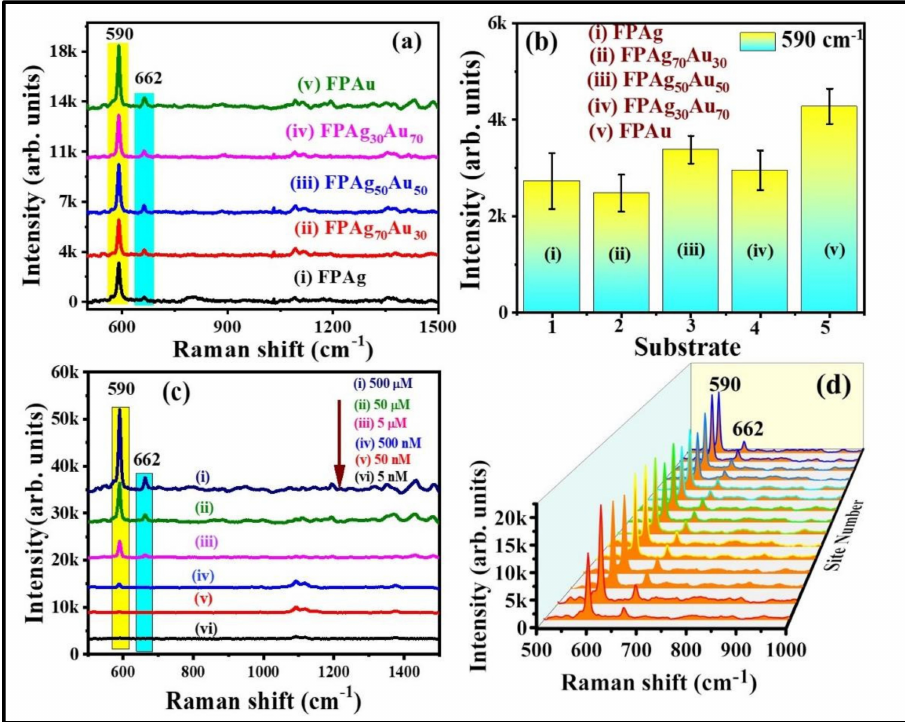
Figure 5. ( a ) SERS spectra of NB (5 µ M) recorded from (i) FPAg (ii) FPAg 70 Au 30 (iii) FPAg 50 Au 50 (iv) FPAg 30 Au 70 (v) FPAu substrates. ( b ) Histogram plot of SERS signal intensity at 590 cm − 1 modes recorded on each substrate. Integration time is 15 s. Errors bars were estimated by measuring the standard deviation of 590 cm − 1 peak SERS average intensity obtained from five repetitive SERS measurements on each substrate. ( c ) SERS signals of NB at varying concentrations [from (i) 500 µ M to (vi) 5 nM] ( d ) 3D SERS spectra of NB (500 µ M) collected from randomly selected 15 sites on FPAu substrate. Integration time was 15